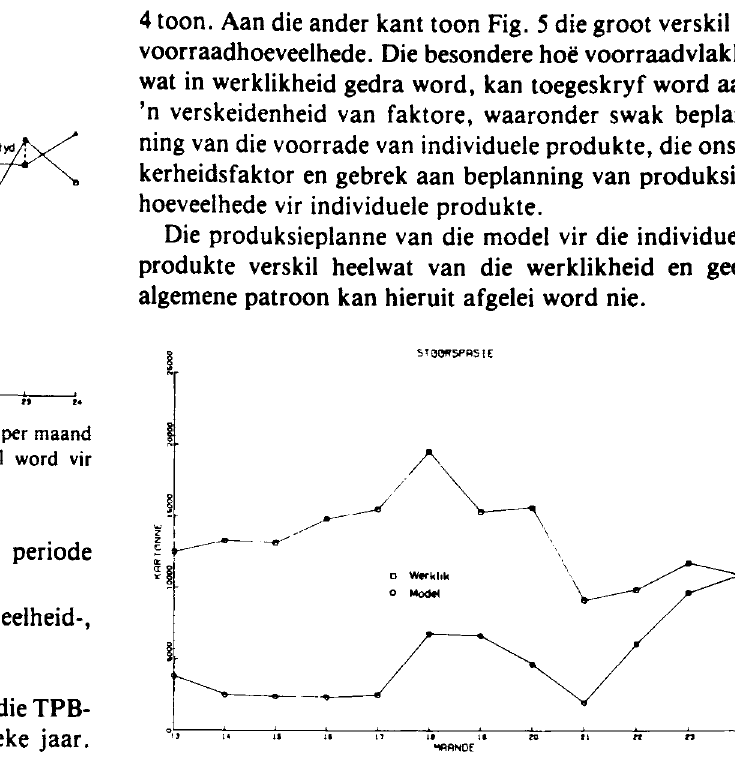
Fig. S 'n Vergelyking tussen die hoeveelheid stoorspasie wat werklik gebruik is en wat deur die model voorgestel word vir minimum koste. Die vergelyking wat hier gedoen is, is in wese